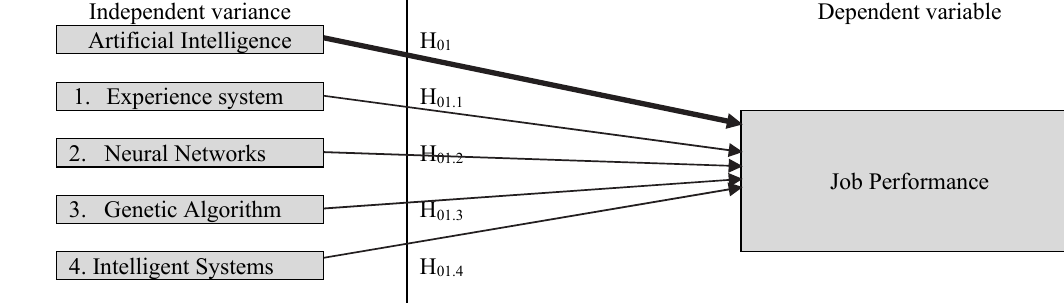
Fig. 2. The proposed